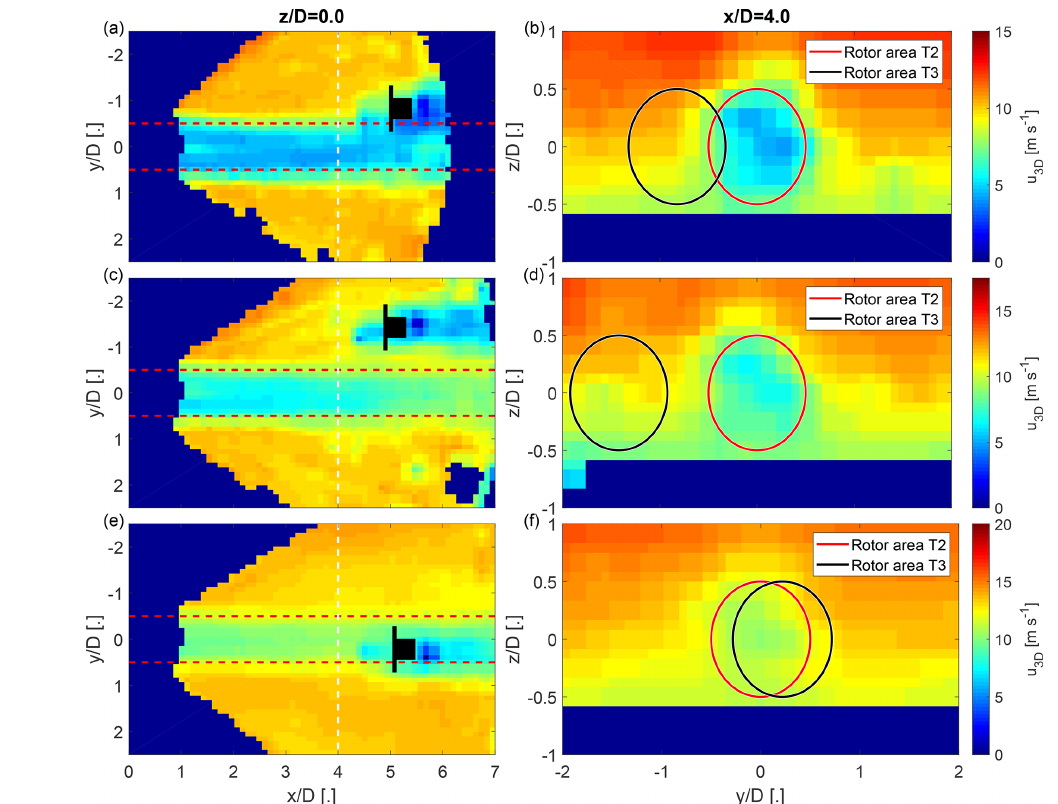
Figure 13. Three examples selected from the wake-steering cases to illustrate successful and detrimental cases of wake-steering. Panels (a) and (b) show a successful wake-steering case. Panels (c) and (d) show an unnecessary wake-steering case. Panels (e) and (f) show a harmful wake-steering case. The colour scale shows the longitudinal velocity of the wake-scanning Doppler lidar. The left column shows a horizontal cross section of the longitudinal velocity at hub height. The right column shows span-wise cross sections of the longitudinal velocity at a downwind distance of 4 D . The dashed red lines and solid red circles show the outline of the rotor area of T2 in wind direction. The position of T3 is stylized in black, and the solid black circle shows the rotor area of T3.